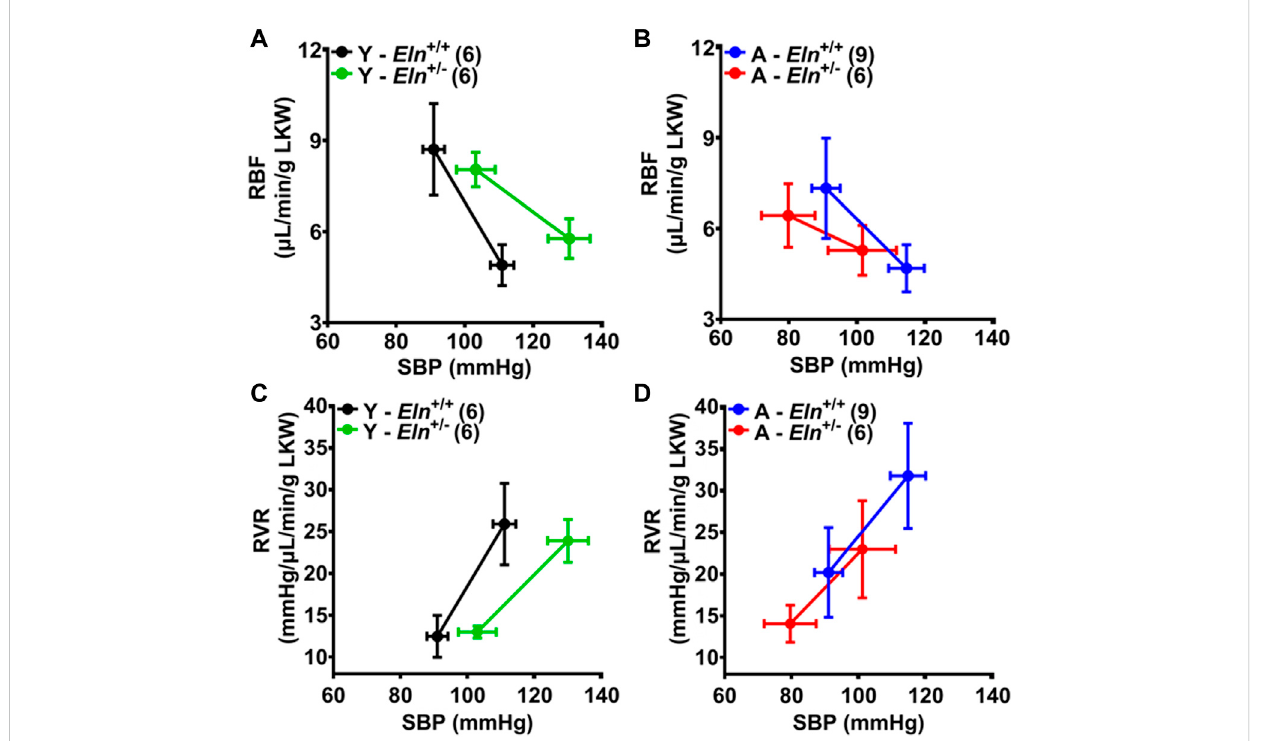
FIGURE 6 Theeffectofagingandelastininsuf fi ciencyonbloodpressure-renalhemodynamicsrelationshipfollowingsimultaneousocclusionoftheceliacand superior mesenteric arteries. (A,B) Systolic blood pressure (SBP) and renal blood fl ow (RBF) in young and aged Eln +/+ and Eln +/ − mice before and after manualocclusionoftheceliacandsuperiormesentericarteries. (C,D) Renalvascularresistance(RVR)inyoungandaged Eln +/+ and Eln +/ − micebeforeand after a manual occlusion of the celiac and superior mesenteric arteries. Data are presented as mean ± s.e.m. Values after occlusion are the maximal SBP, RBF, and RVR responses. LKW, left kidney